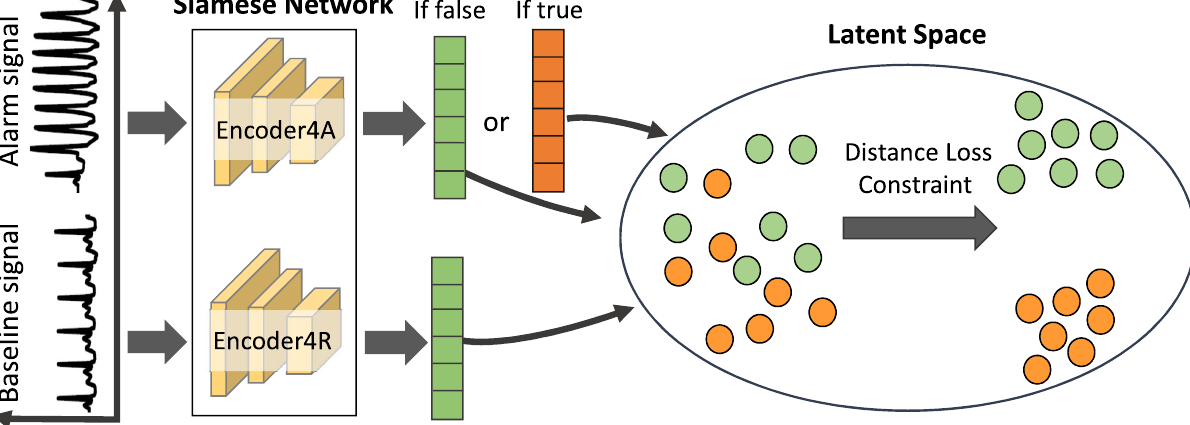
Figure 2. We use the idea of Siamese Network to calculate our discriminative constraint. Here, Encoder4A and Encoder4R take an ‘alarm signal’ and a ‘baseline signal’ sampled from the same waveform record as inputs and output their feature vectors respectively. The distance loss is then used to find the similarity of the inputs by comparing their feature vectors. The ’alarm signal’ refers to the multi-channel waveform segment that triggered the alarm (e.g., 10-s segment prior to the alarm onset), and the ’baseline signal’ segment is randomly sampled from a prior time interval of the same record. Figure generated in PowerPoint version 1808, https:// www. micro soft.